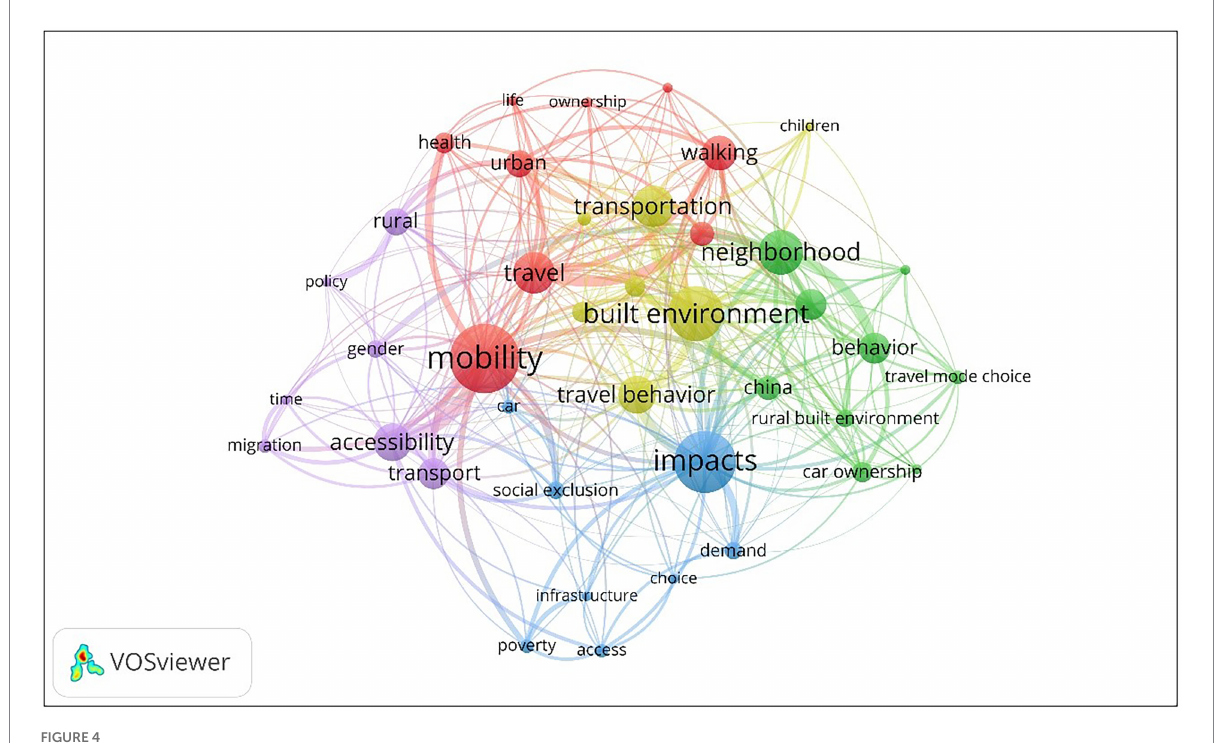
FIGURE 4 Map of co-occurrence of